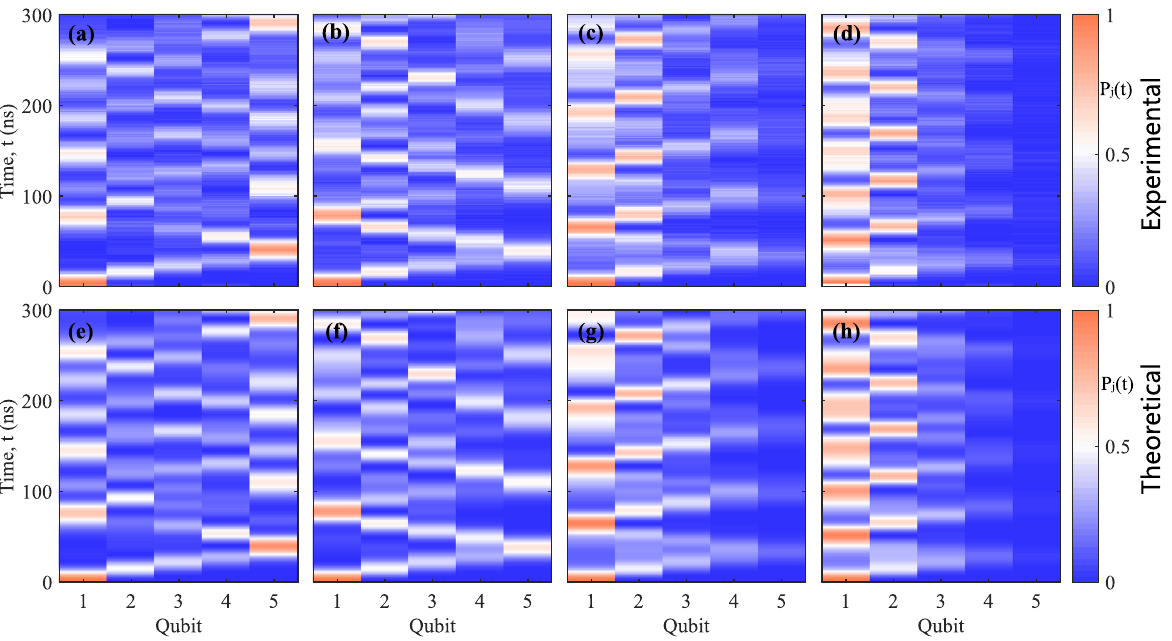
Fig. 2 Spin transport. The experimental results for the time evolution of density distribution P j ( t ) up to 300 ns. The initial state is 10000 j i , and the potential gradient ( a ) F /2 π = 0, ( b ) F /2 π = 5, ( c ) F /2 π = 10, ( d ) F /2 π = 15 MHz. The photon or the spin can exhibit a light-cone-like spreading in the system. As the increase of F , the photon becomes more dif fi cult to propagate to the right boundary, instead, it tends to oscillate in the vicinity of the initial position. Each point shows the average of 6 × 100 single-shot measurements. e – h The corresponding theoretical results of a – d . The numerical and experimental results are consistent with each other. The details of numerical method are presented in “ Methods ”